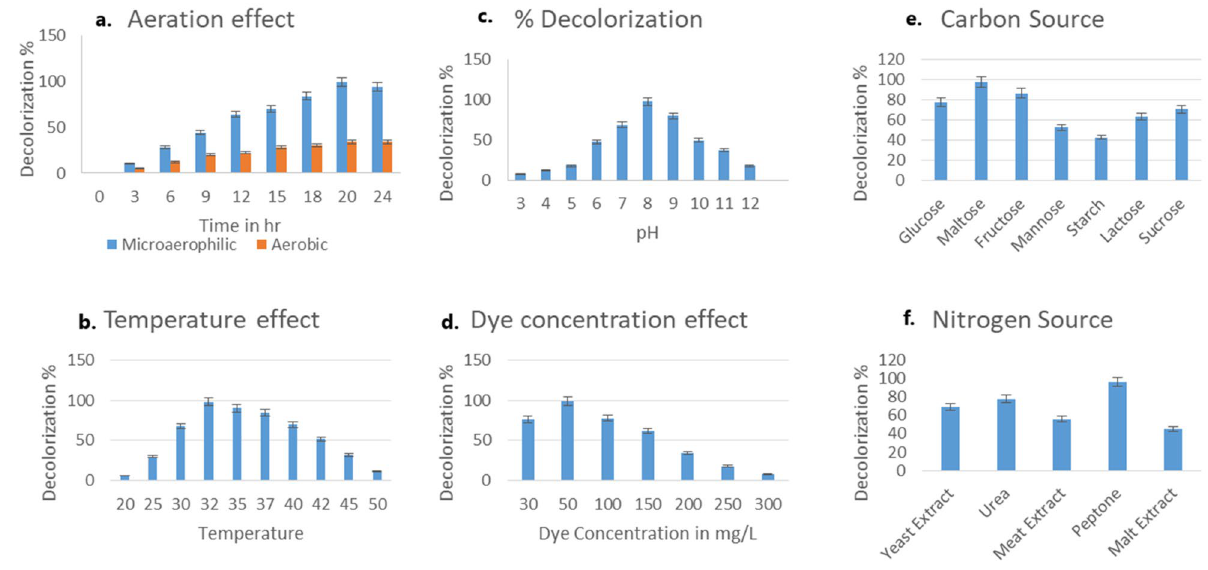
Figure 1. Effect of Environmental and nutritional factor on decolourization %. ( a ) Effect of aeration, ( b ) Effect of temperature, ( c ) Effect of pH, ( d ) Effect of dye concentration, ( e ) Effect of carbon sources, and ( f ) Effect of nitrogen